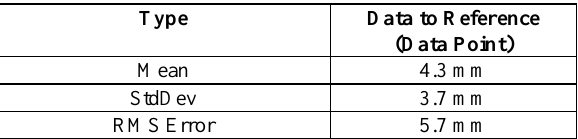
Table 6 Deviation statistics between NextEngine and our proposed system